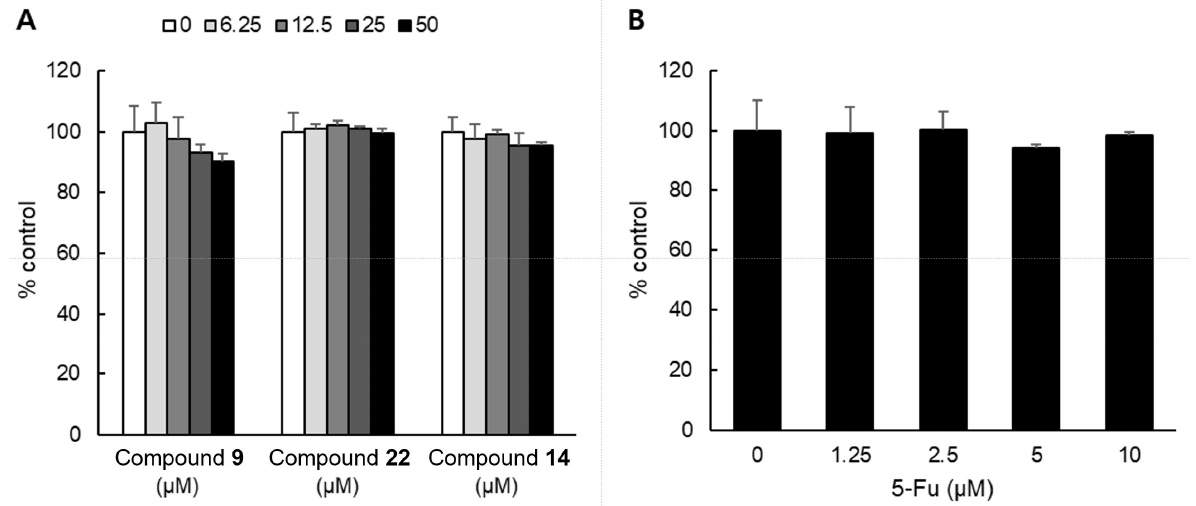
Figure 7. Cytotoxicity of compounds 9 , 14 , and 22 in NHDF cells. NHDF cells were treated ( A ) various concentrations of each compound (0 to 50 µM) and ( B ) various concentrations of 5-Fu (0 to 10 µM). Cell growth was determined by WST-8 assay.